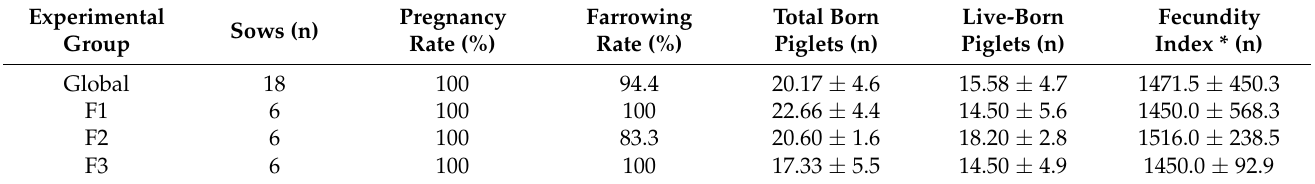
Table 5. Pregnancy rate (%), farrowing rate (%), total-born piglets, live-born piglets, and ± fecundity index (mean ± standard deviation) in sows inseminated with the three experimental groups (F1, F2, F3). The global group includes the data of all the sows used in the